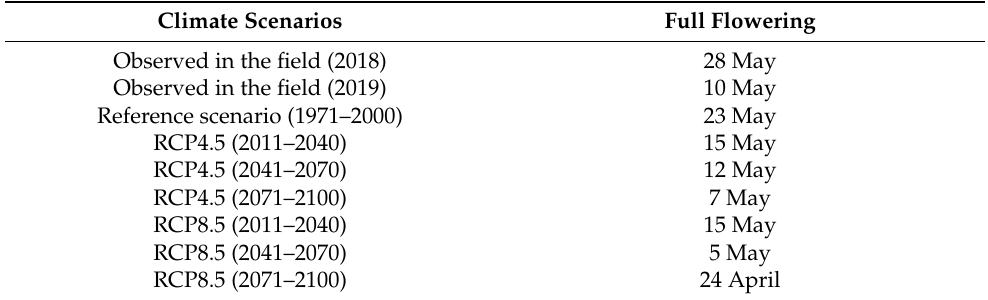
Table 5. Full flowering dates observed in 2018 and 2019 and estimated for the climate scenarios.